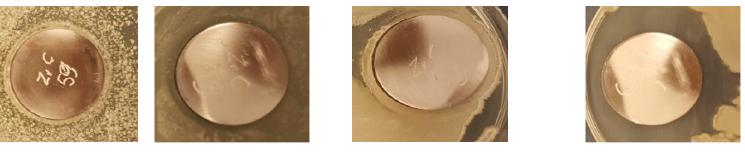
Figure 8. Antibacterial activity of the sample coated with Zr–C (63 at.% C) coating against bacterial strains based on the inhibition zone test.